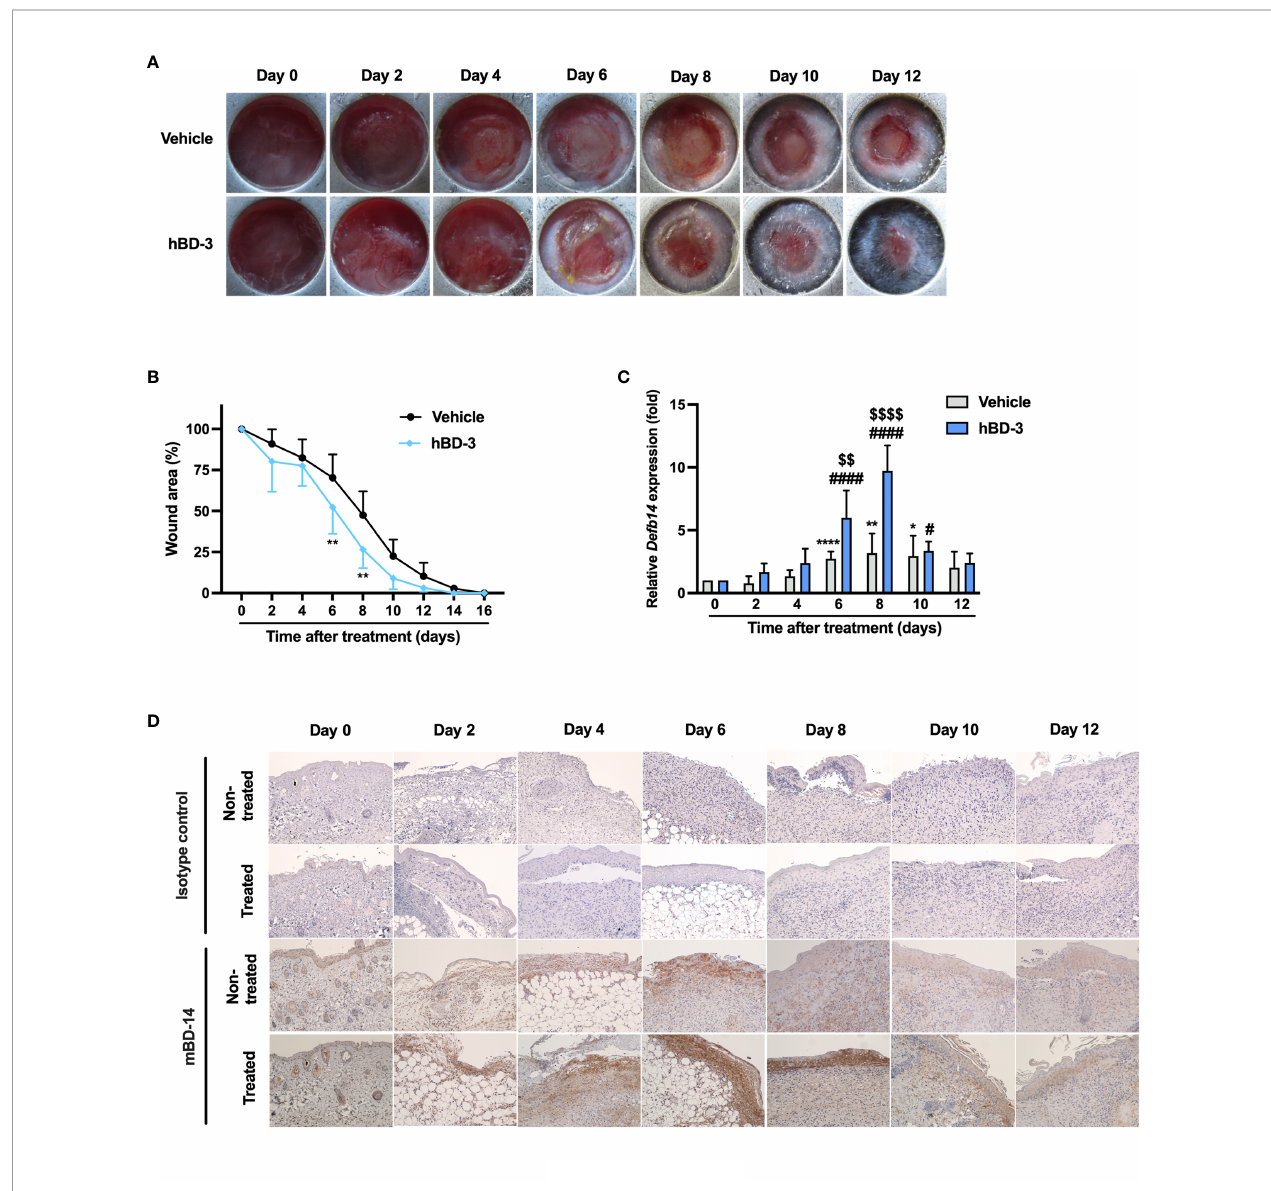
FIGURE 1 | hBD-3 accelerates wound closure in vivo. Dorsal full-thickness skin wounds were created on mice and then topically treated with 0.01% acetic acid (vehicle) and 200 µg/ml hBD-3. (A) Representative images of skin wounds from day 0 to day 12. (B) The average wound area was calculated using ImageJ software. The P value was evaluated using one-way ANOVA with Tukey ’ s multiple comparisons test. * P < 0.05 and ** P < 0.01 between the vehicle-treated wounds and the hBD-3-treated wounds. n = 3 wound areas/group. (C) mRNA was extracted from the wound tissues and the mRNA expression of Defb14 (mBD-14) was detected by quantitative real-time PCR analysis using SYBR Premix Ex Taq. The P value was determined by one-way ANOVA with Tukey ’ s multiple comparisons test. * P < 0.05, ** P < 0.01 and **** P < 0.0001 for comparisons between the vehicle-treated wounds. # P < 0.05 and #### P < 0.0001 for comparisons between hBD-3- treated wounds. $$ P < 0.01 and $$$$ P < 0.0001 for comparisons between the vehicle-treated and hBD-3-treated wounds. n = 3. (D) Representative images of mBD-14 staining and isotype control staining in treated and nontreated wounds from day 0 to 12. Original magni fi cation: